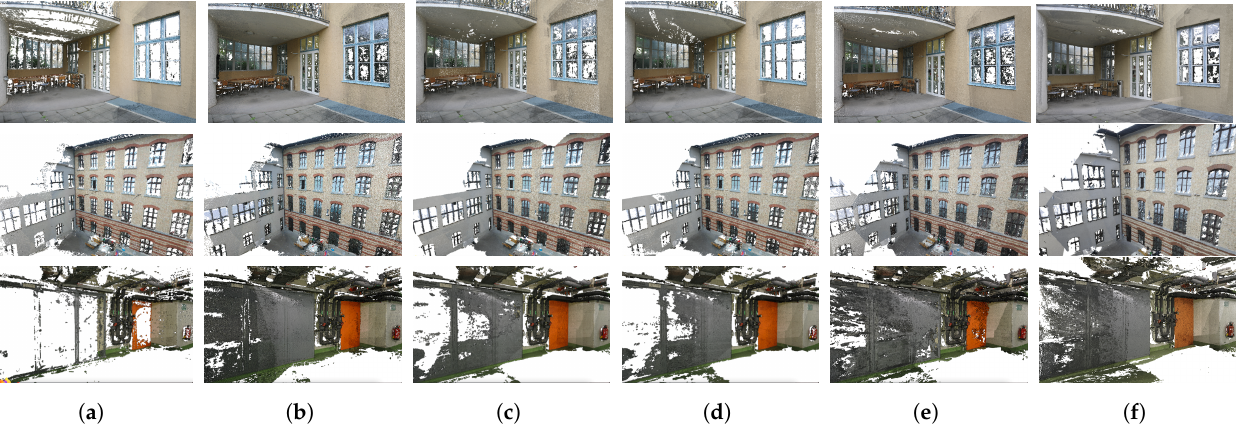
Figure 7. Qualitative point cloud comparison of our method with other state of the art algorithms for the ETH3D benchmark sequences terrace , courtyard and pipes . Dense reconstructions for the state of the art methods are as in ETH3D evaluation site. Table 1. Accuracy, completeness and F 1 score comparisons for tolerance τ = 2 cm and τ = 10 cm for the ETH3D benchmark datasets. Values for the other methods are taken from the ETH3D evaluation site. Best values in bold. τ = 2 cm τ = 10